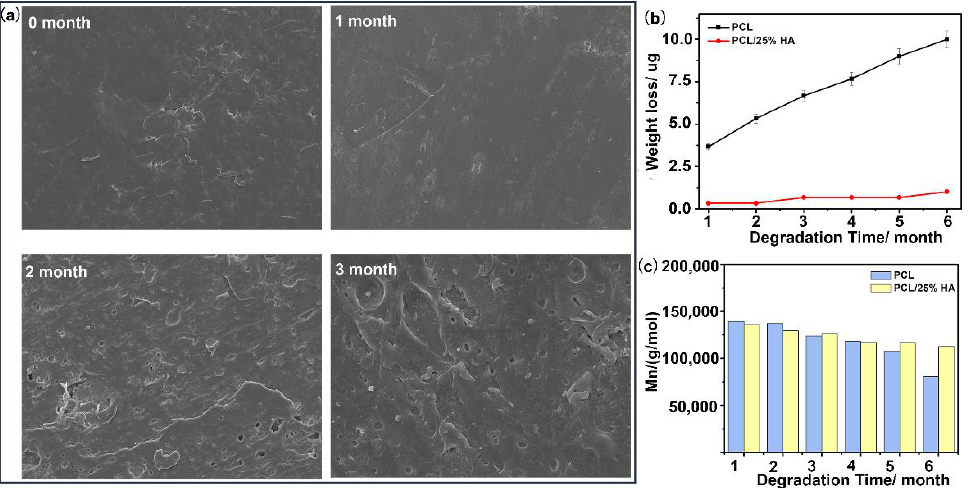
Figure 5. The degradation behaviors of the PCL/25%HA scaffolds in PBS. ( a ) SEM micrographs of PCL/25%HA scaffolds in PBS for 3 months; ( b ) Weight loss and weight-average molecular weight (Mn) of the PCL/HA scaffolds with 0 and 25% HA content after 6 months of degradation.